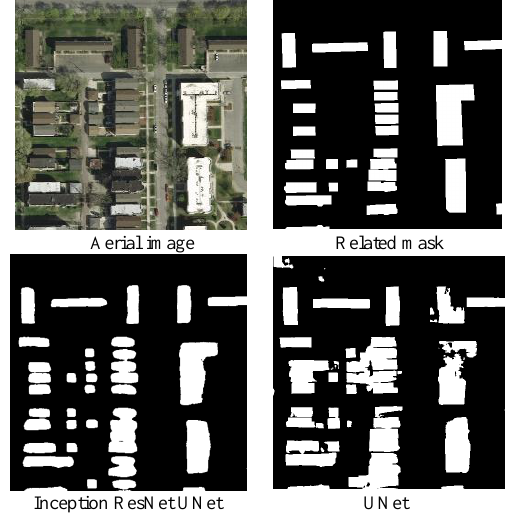
Figure 7. The edges in Inception ResNet UNet are detected more precisely in comparison with